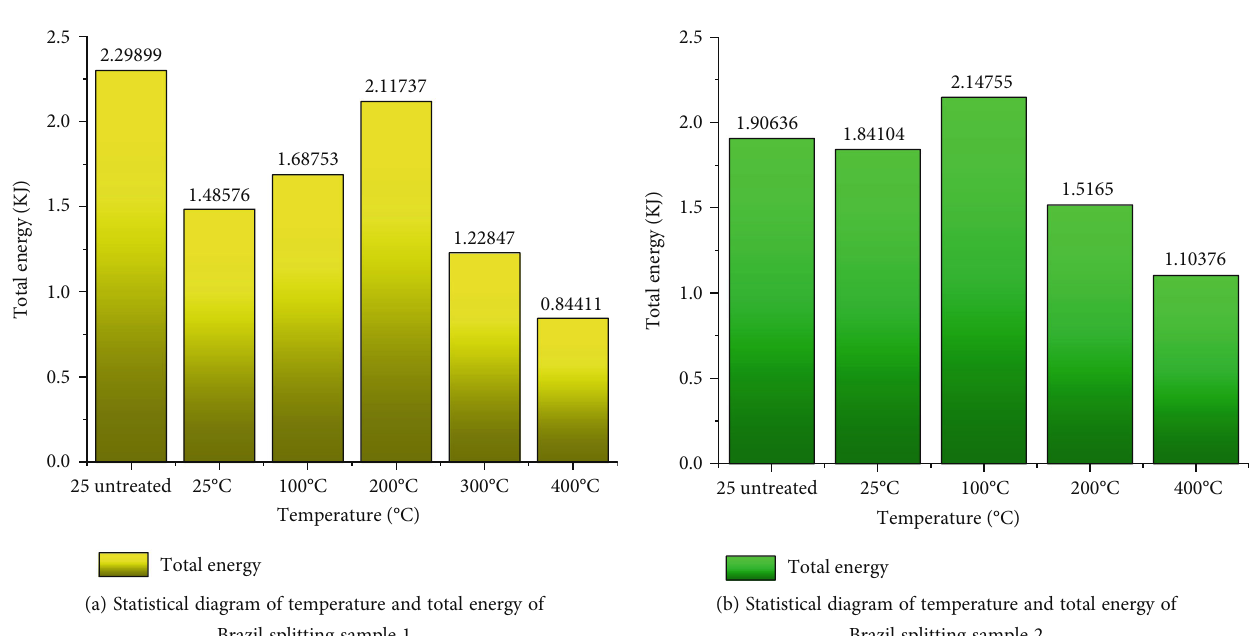
Figure 16: Statistical diagram of temperature and total energy of Brazil splitting experiment.